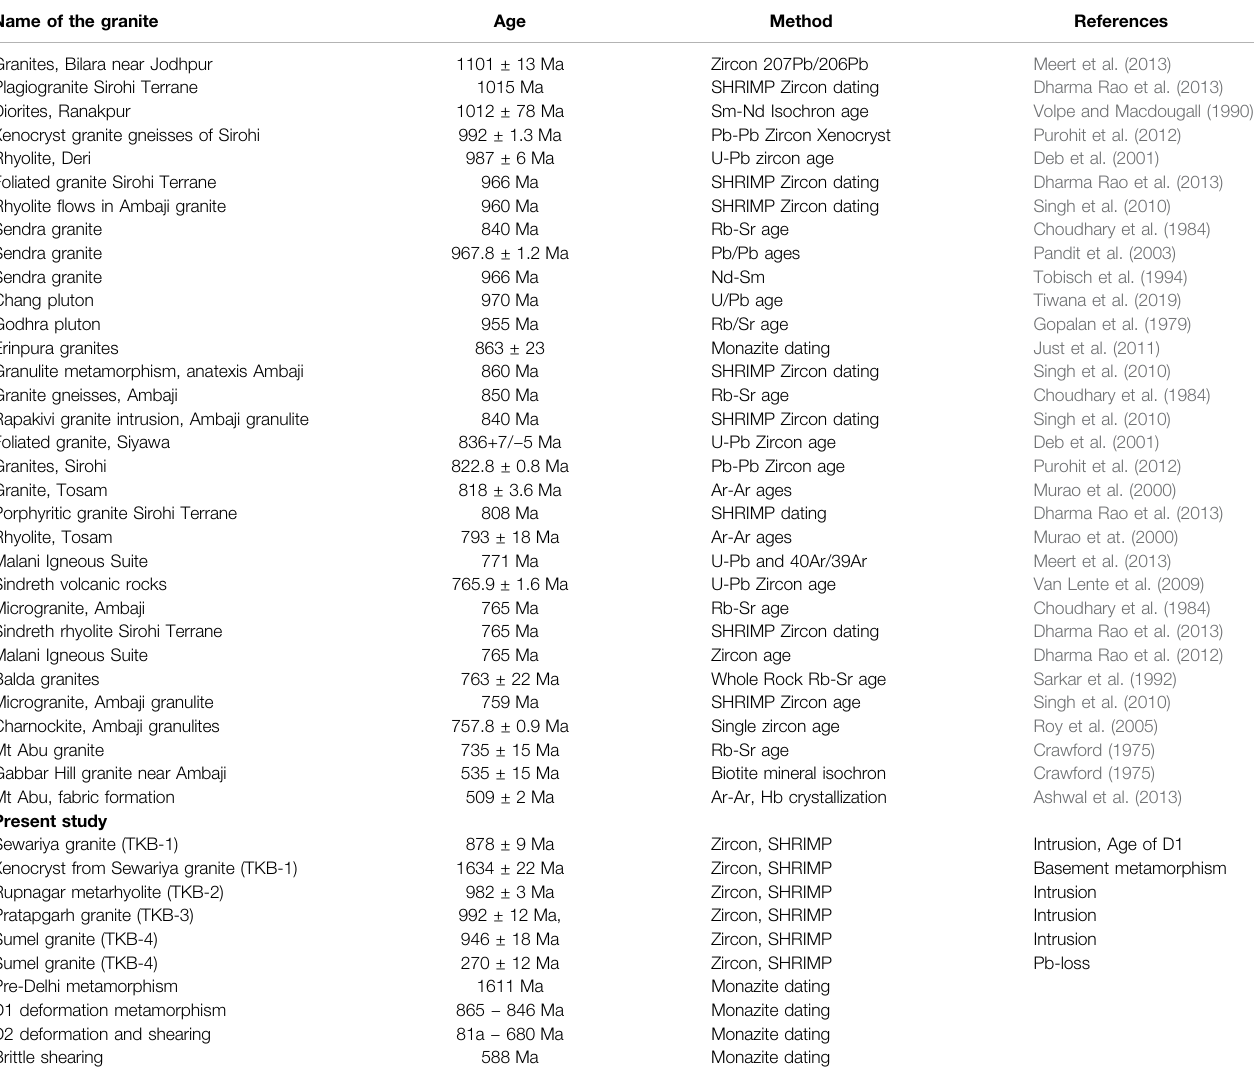
TABLE 1 | Granite ages, from the SDT. Name of the